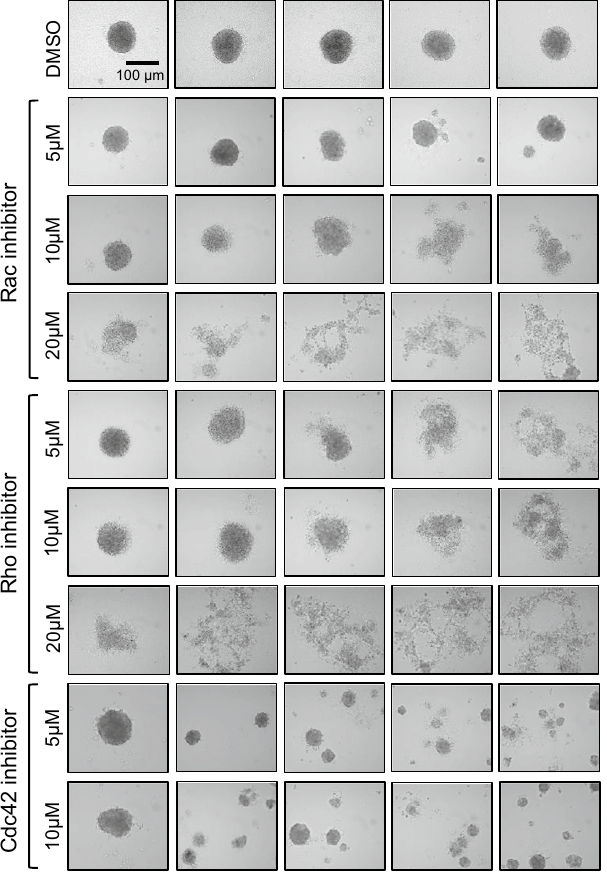
Figure 3. Inhibition of Rac, Rho, or Cdc42 activation differentially affects VSMC spheroid formation and morphology. Human VSMCs treated with Rac (EHT1864), Rho (Rhosin), and Cdc42 (ML141) inhibitors or DMSO (vehicle control) were used to generate human VSMC spheroids. VSMC spheroids were imaged after 24 h of incubation using an upright phase-contrast